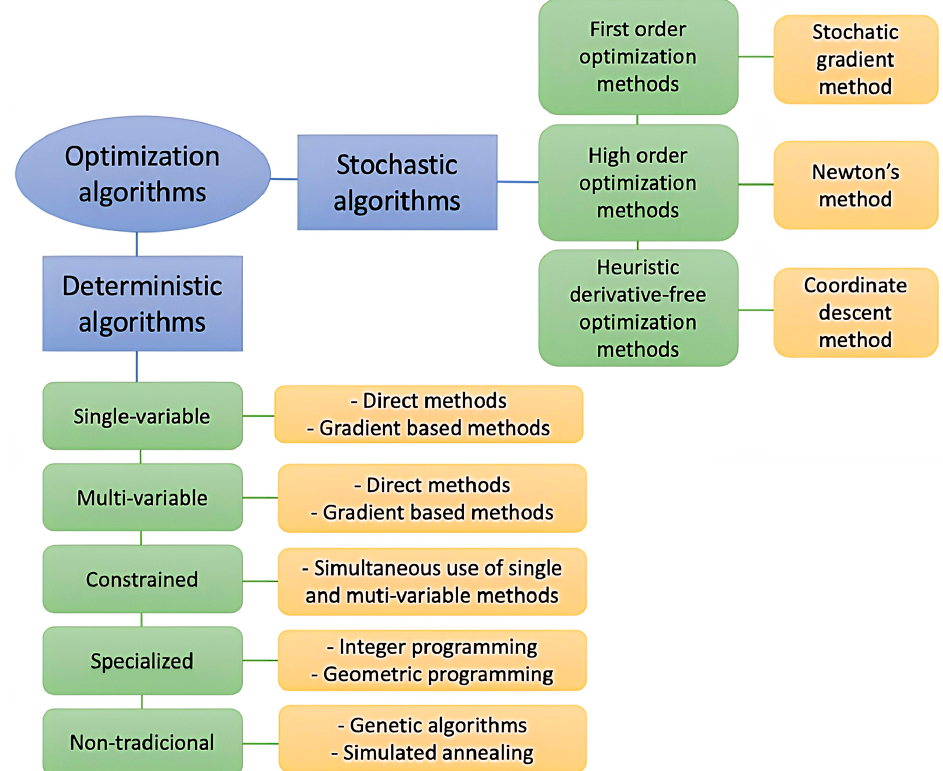
Figure 11. Classification of optimization algorithms based on the design variables, objective function and type of constraints.